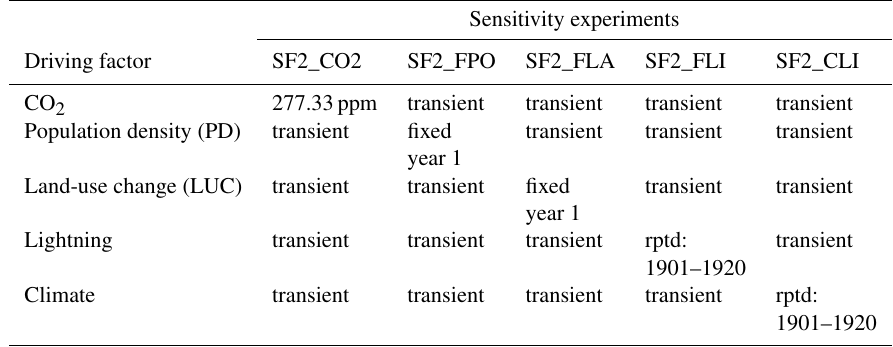
Table 1. Overview over the sensitivity experiments conducted by FireMIP models (Rabin et al., 2017a). Rptd indicates the forcing was repeated over the given years. SF2_CO2 stands for fixed atmospheric CO 2 concentration, SF2_FPO for fixed population density, SF2_FLA for fixed land use, SF2_FLI for fixed lightning and SF2_CLI for fixed climate.